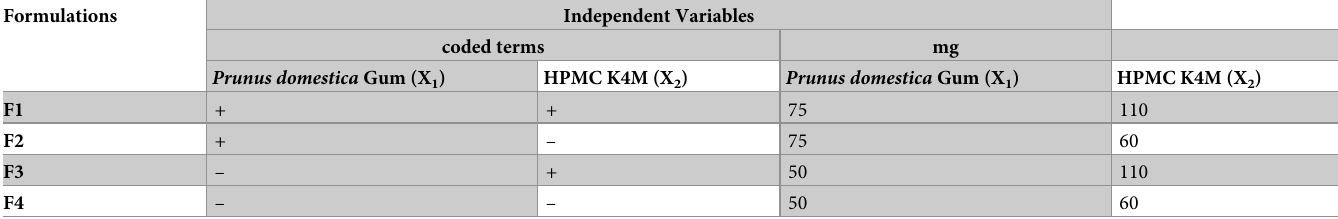
Table 1. Representation of 2 2 full factorial design.